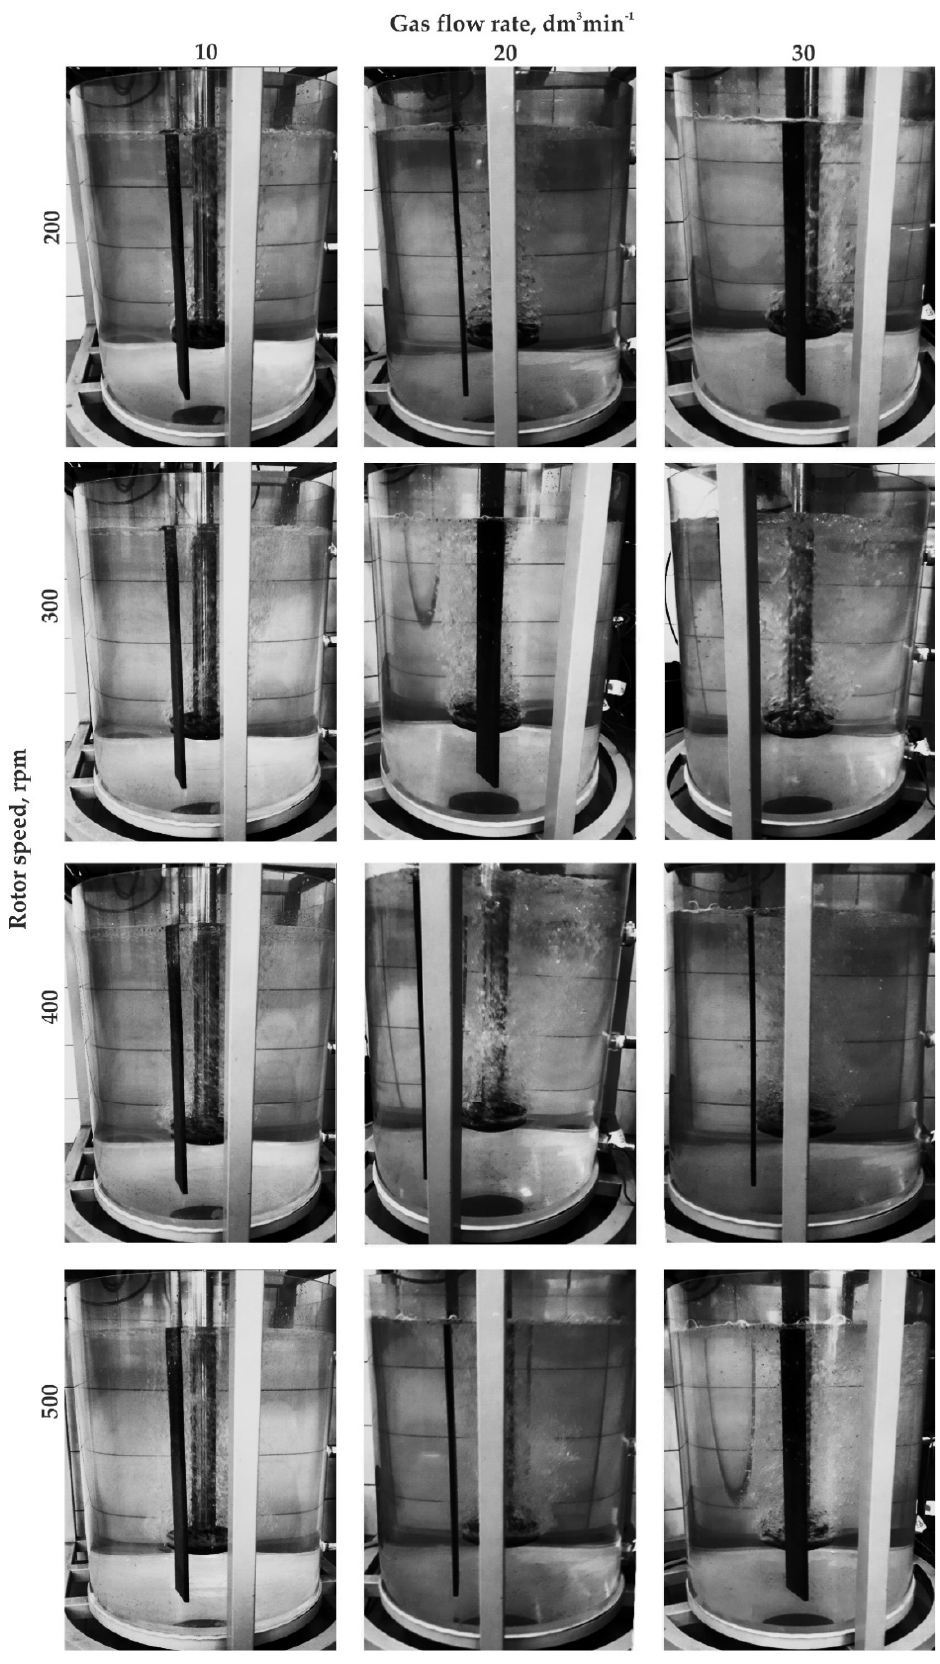
Figure 13. Gas bubble dispersion registered for different processing parameters (impeller variant B12).